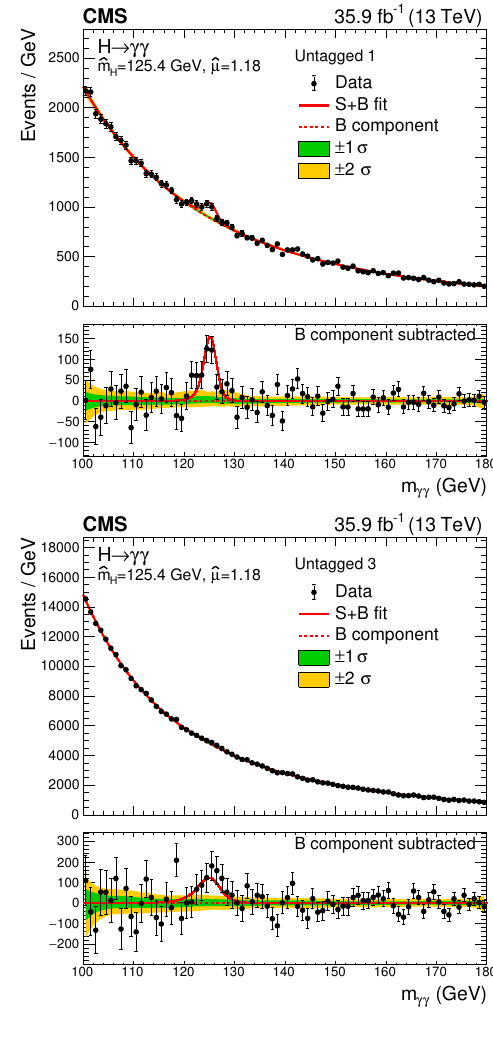
Figure 11 . Data and signal-plus-background model (cid:12)ts in the four untagged categories are shown. The one (green) and two (yellow) standard deviation bands include the uncertainties in the back- ground component of the (cid:12)t. The lower panel in each plot shows the residuals after the background